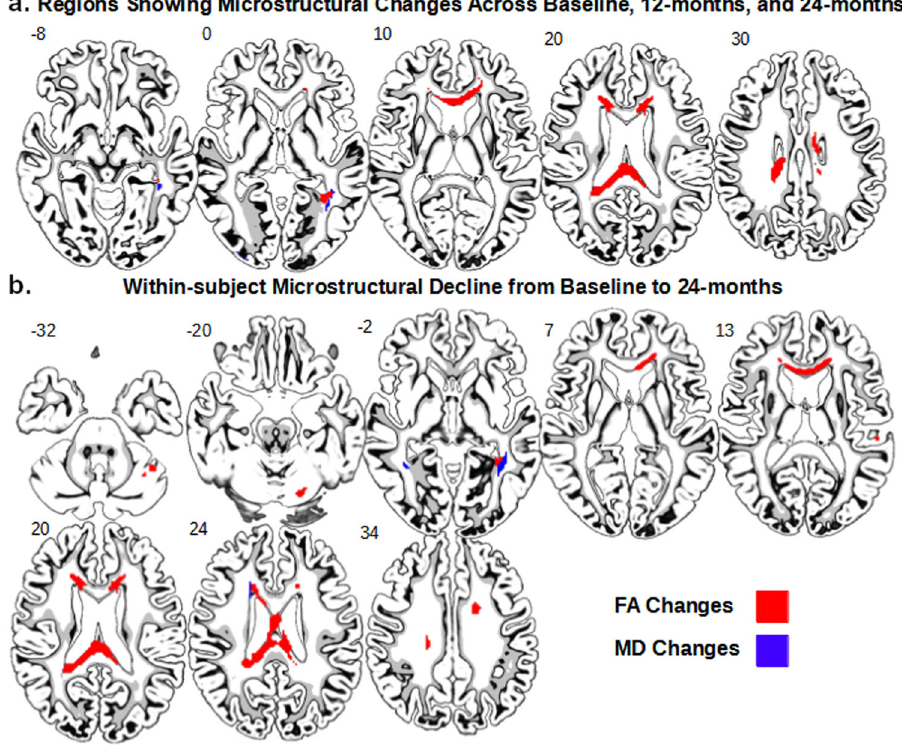
Fig. 1 Whole-brain voxel-wise analysis of callosal changes across 24 months. a Whole-brain ANOVA data. Suprathreshold clusters show FA (red) and MD (blue) changes across the baseline, 12-month, and 24-month follow-up time-points (FDR p < 0.05). b Results from paired t tests comparing the baseline and 24-month time-points. Suprathreshold clusters show a within-subject microstructural decline (FDR p < 0.05). Red indicates areas where FA decreased over time, and blue indicates areas where MD increased over